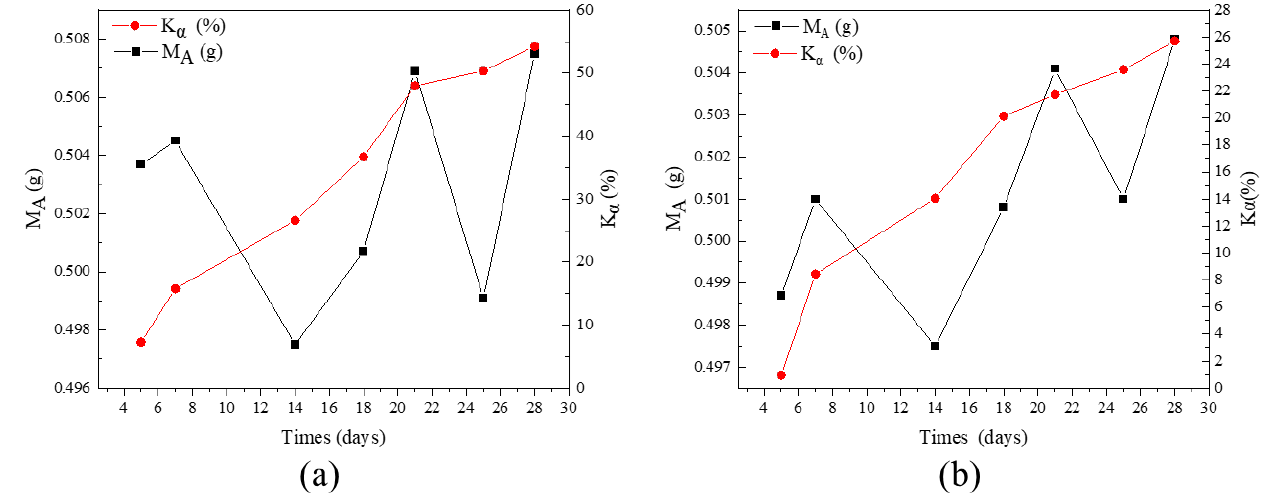
Figure 2. Determination of pozzolanic activity using the residue method: ( a ) CAG; ( b ) CMT.